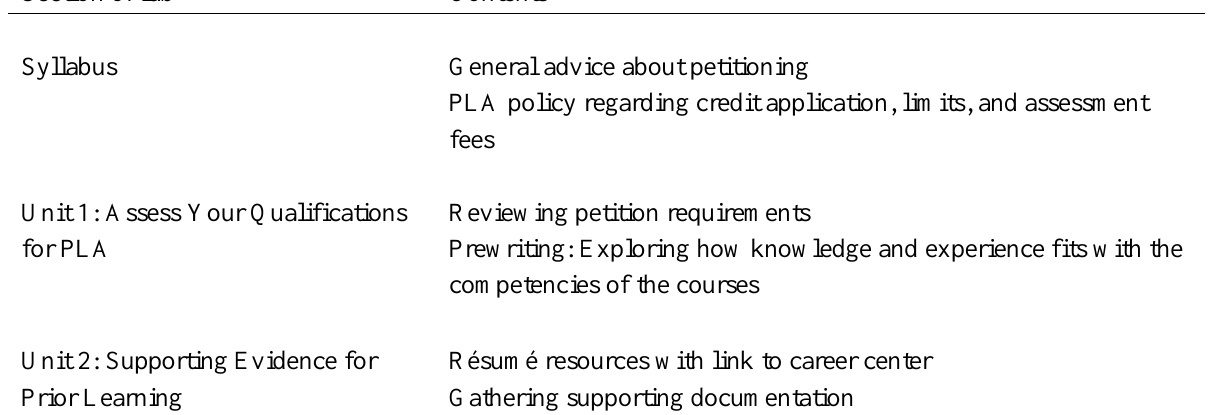
Table 1 Lab Outline Section of